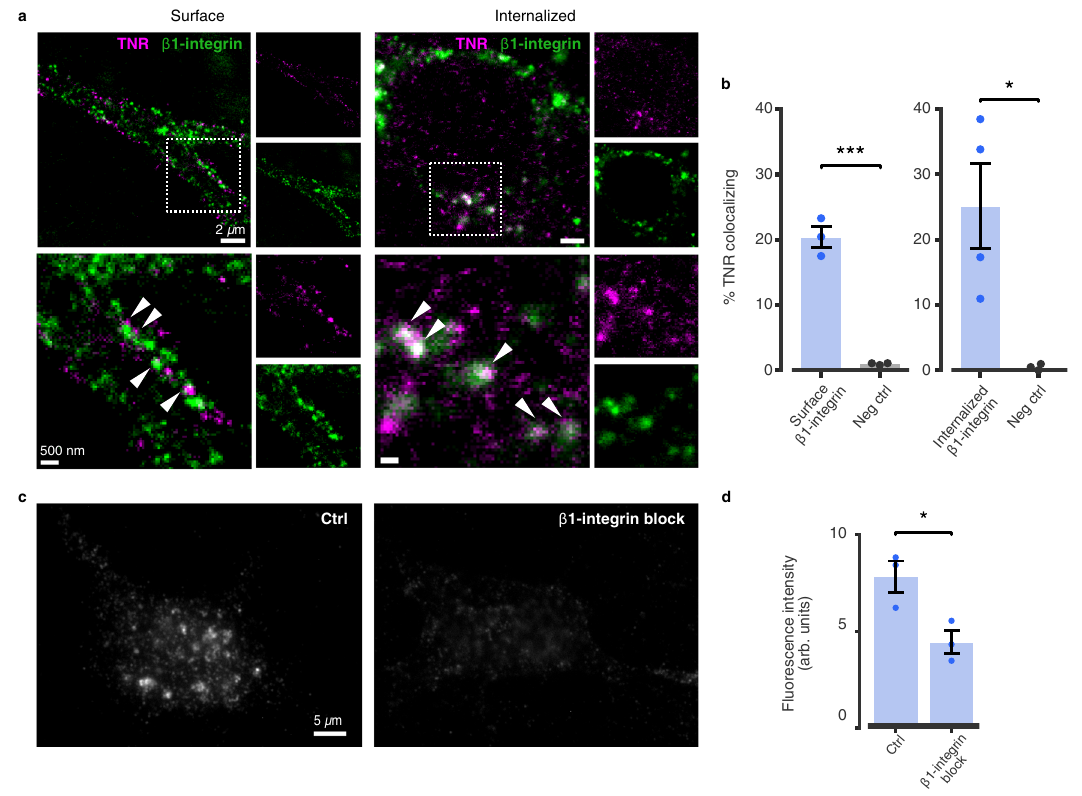
Fig. 7 TNR recycling is mediated by integrins. a , b Assessment of colocalization between recycling TNR molecules and β 1-integrin. a Left: newly-emerged TNR epitopes were labeled 12 h post-blocking concurrently with a labeling of surface-bound β 1-integrins, by applying fl uorophore-conjugated antibodies directed against the extracellular domain of the receptors. The neurons were fi xed and imaged with 2-color-STED. Right: newly-emerged TNR epitopes were labeled 4 h post-blocking, concurrently with β 1-integrin. Neurons were incubated a further 12 h to allow for internalization, and remaining surface- bound molecules were stripped with proteinase K. The neurons were fi xed and imaged with confocal microscopy. Images on the right of each panel show zoomed views of the dashed boxed. Scale bars = 2 µ m (full images), 500 nm (zoomed images). b Quanti fi cation of % colocalizing TNR signal (for a ) shows newly-emerged TNR epitopes colocalize with both cell surface-bound and internalized β 1-integrins. The values are signi fi cantly higher than negatives controls, relying on non-speci fi c primary antibodies. Controls were imaged in STED/confocal for comparison to images in the left/right panels, respectively. N = 3 ( ‘ surface β 1-integrin ’ experiments and negative controls), and 4 ( ‘ internalized β 1-integrin ’ ) independent experiments, ≥ 10 neurons per datapoint. Two-sided Student ’ s t -test ( ‘ surface integrin ’ vs. ‘ neg ctrl ’ : t = 11.61, *** p = 0.0003; ‘ internalized integrin ’ vs. ‘ neg ctrl ’ : t = 3.177, * p = 0.025. Data represent mean ± SEM, dots indicate individual experiments. c To assess whether β 1-integrin receptors are required for TNR endocytosis, newly-emerged TNR epitopes were labeled 12 h post-blocking, after which the neurons were immediately incubated with function-blocking anti- β 1-integrin antibodies 33 for 6 h. Neurons were then incubated with proteinase K, to remove remaining surface-bound TNR, and imaged with epi fl uorescence microscopy. A reduction in fl uorescence signal is evident in integrin-blocked cultures. Scale bar = 5 μ m. d Quanti fi cation of the fl uorescence intensity con fi rms that the amount of internalized TNR is signi fi cantly reduced following the blocking of β 1-integrin receptors. N = 3 independent experiments, ≥ 15 neurons per datapoint. Two- sided Student ’ s t -test ( t = 3.343, * p = 0.029). Data represent mean ± SEM, dots indicate individual experiments. Source data are provided in Source Data fi